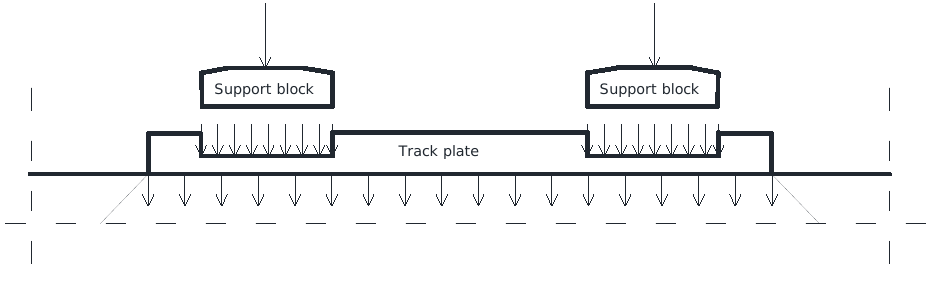
Figure 7. Load distribution model adopted for the test.